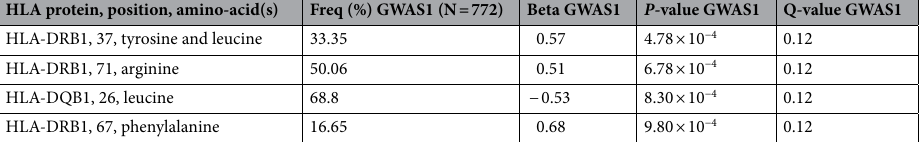
Table 2. Best results of association analysis of HLA with response to Li as continuous trait for group GWAS1 in additive model. Freq: frequency; Q-value: the q -value gives the expected positive false discovery rate.